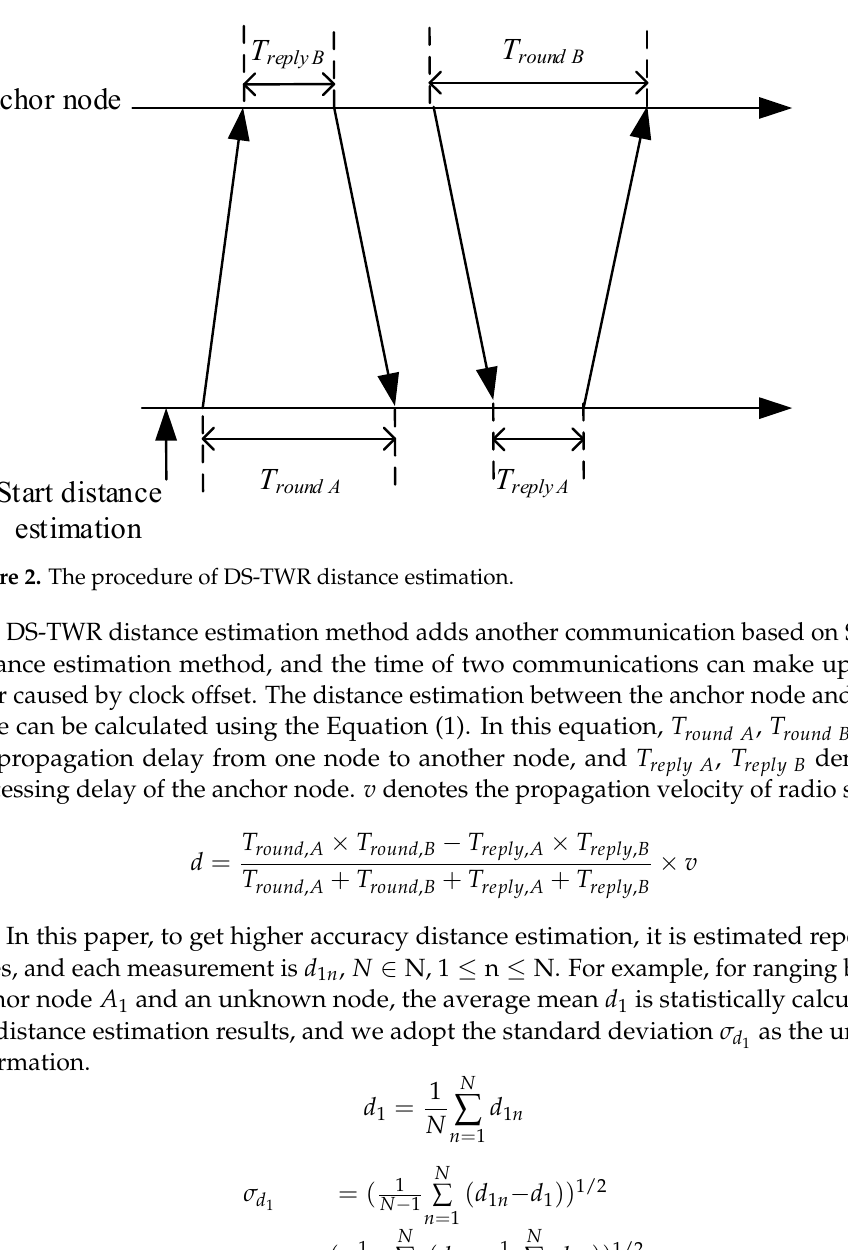
estimation method. We show the procedure of a DS-TWR distance estimation between an unknown node and an anchor node in Figure 2.